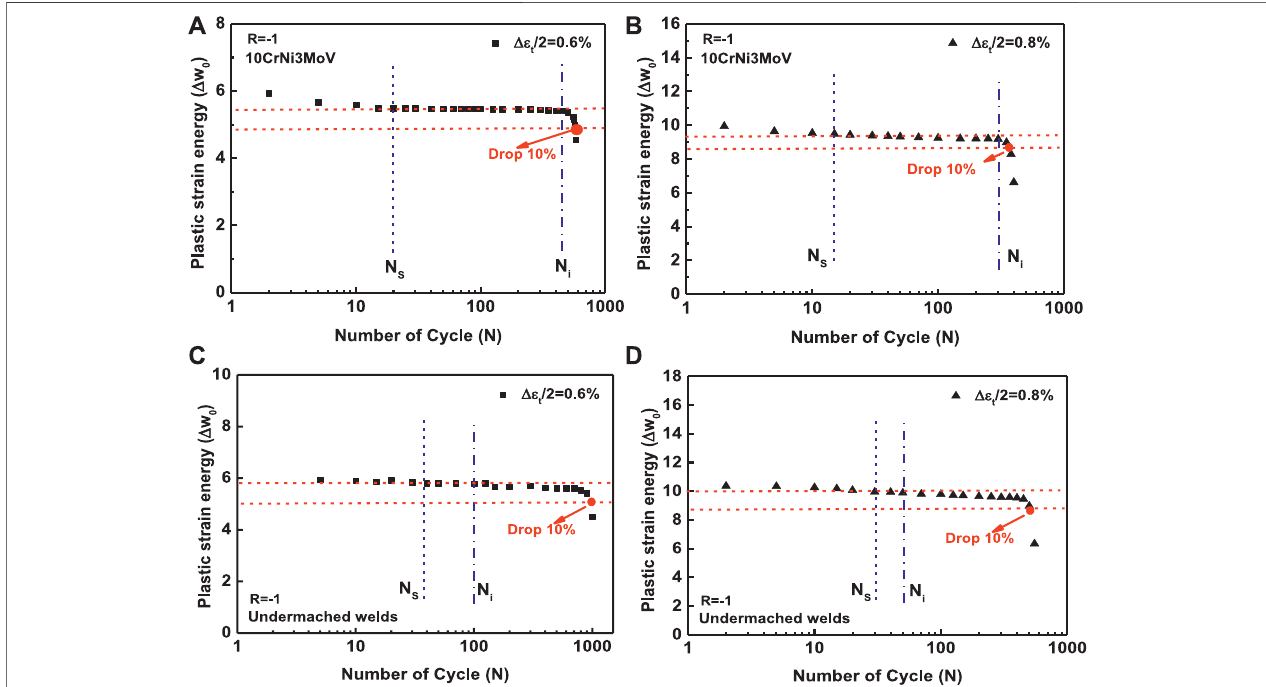
FIGURE10| Theevolutionofplasticstrainenergydensity Δ w 0 withcycles. (A) Δ ε t /2 (cid:1) 0.6%for10CrNi3MoVsteel, (B) Δ ε t /2 (cid:1) 0.8%for10CrNi3MoVsteel, (C) Δ ε t /2 (cid:1) 0.6% for undermatched welds, and (D) Δ ε (cid:1) 0.8% for undermatched welds. t /2